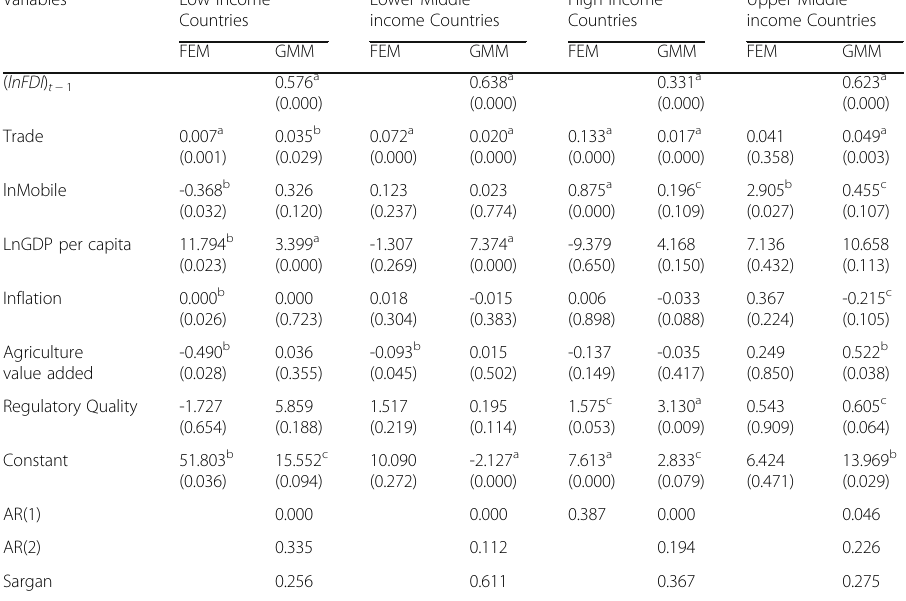
Table 13 Regulatory Quality and